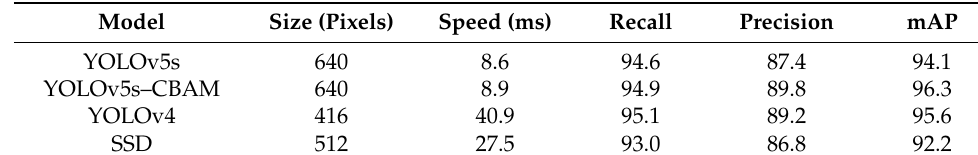
Table 2. Performance of detectors on the watermelon test dataset.